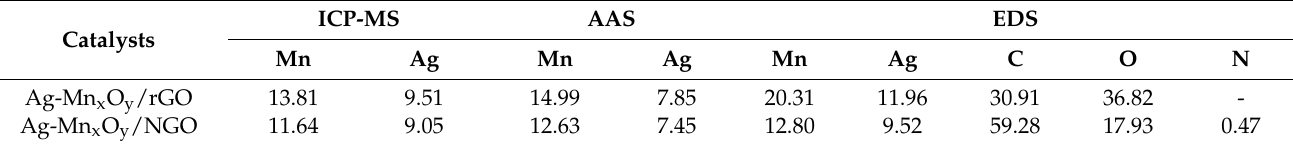
Table 2. Elemental composition results of the Ag-Mn x O y /C catalysts (wt.%).